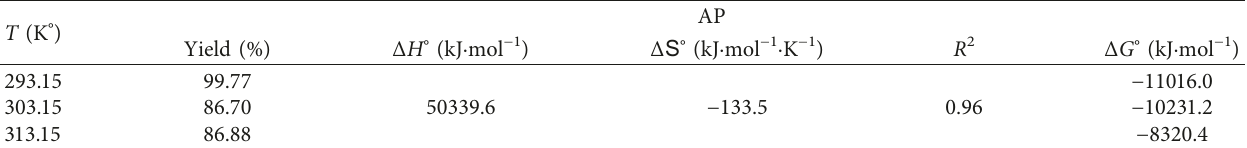
Figure 16: Kinetic model of intraparticular Table 6: Thermodynamic parameters of adsorption of methyl green on purified clay.